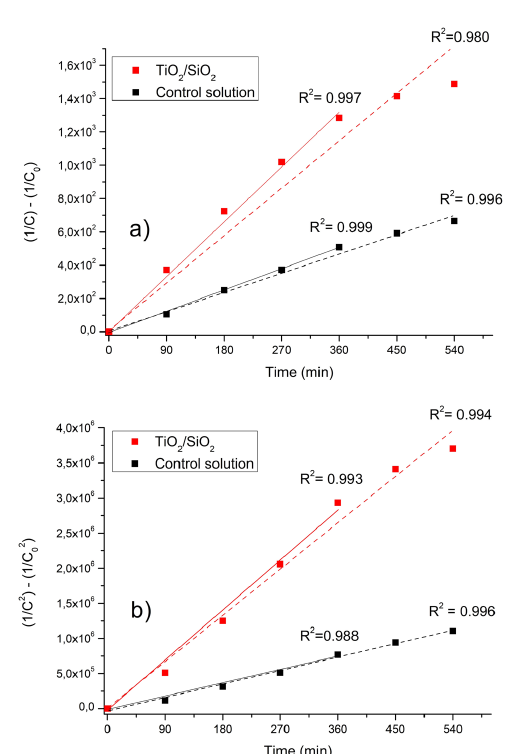
Figure 5. Linearization of 2 nd (a) and 3 rd (b) order kinetics from the concentration (g/L), obtained from the photocatalysis with the TiO SiO sample and from the photodegradation of methylene blue in a 2 control solution in the 16 th test cycle of the material stability. The solid lines correspond to the fits up to 360 min, while the dashed lines correspond to all data